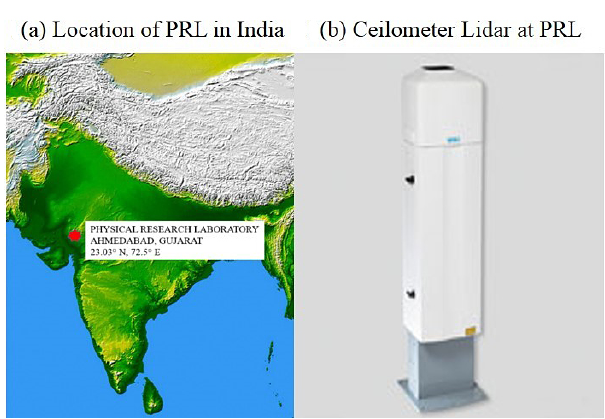
Figure 1. (a) Location of Ahmedabad (23.03 ◦ N, 72.54 ◦ E; 55ma.m.s.l.), where Ceilometer CL31 is installed, and (b) a photo- graph of the Vaisala